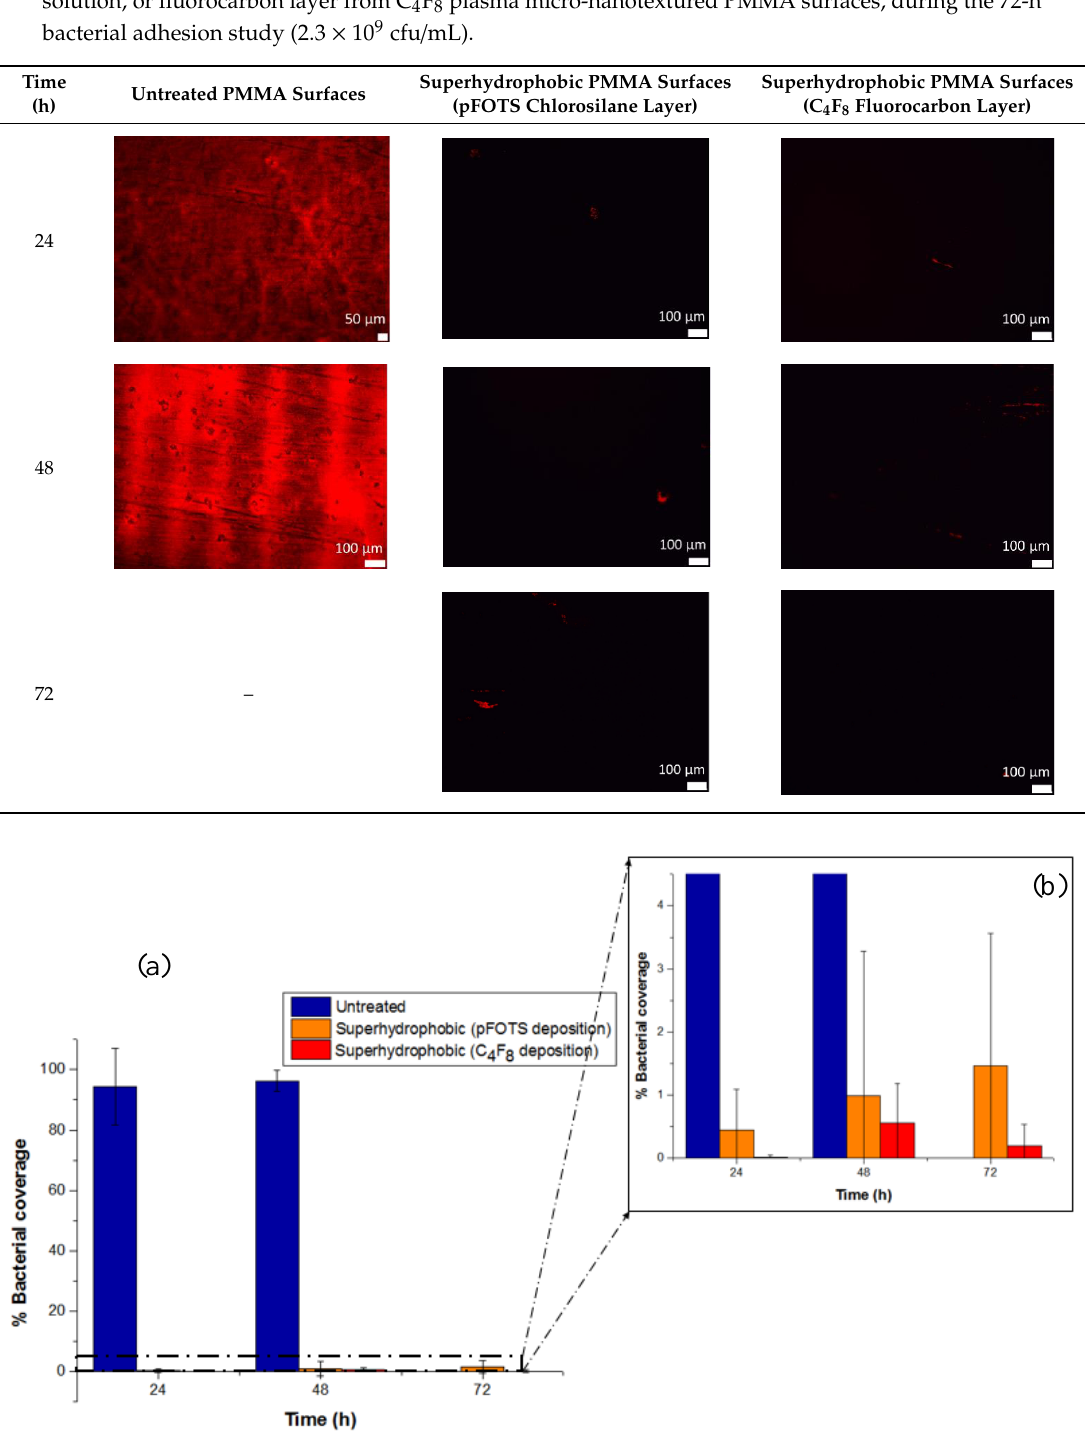
Figure 3. ( a ) Percentage bacterial coverage of untreated and superhydrophobic PMMA surfaces (deposition of chlorosilane layer from pFOTS solution, or fluorocarbon layer from C 4 F 8 plasma). ( b ) Magnified image to clearly present the low % bacterial coverage (not exceeding 1.5%) of both superhydrophobic surfaces, demonstrating superior bacteria anti-adhesive